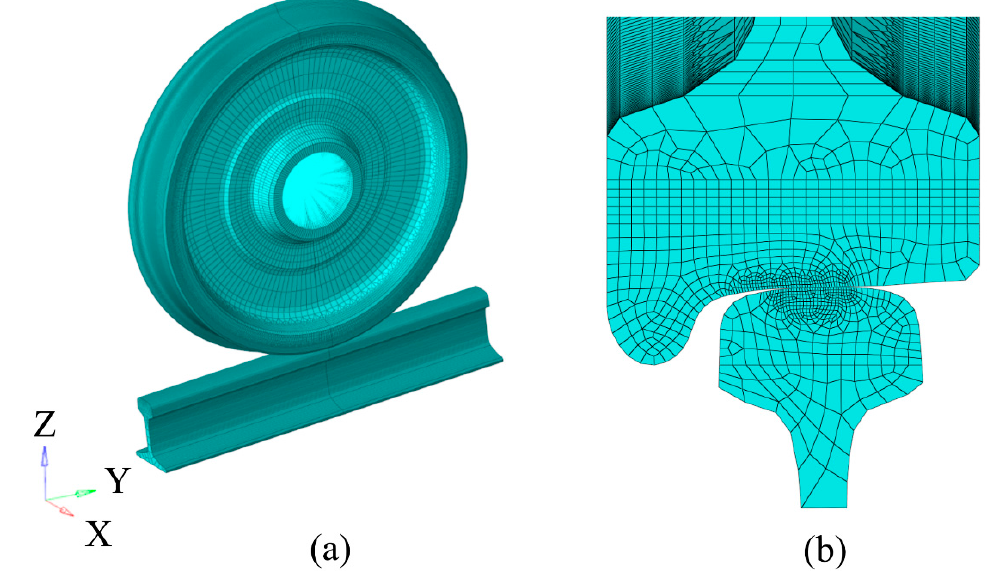
Figure 1. Three-dimensional wheel-rail rolling contact finite element model. ( a ) wheel-rail rolling contact overall model, ( b ) local refinement of contact area.